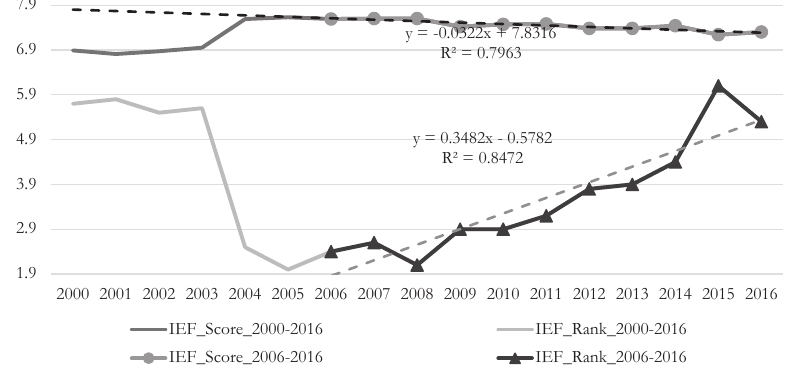
Fig. 1 – The Fraser Institute Economic Freedom. Source: own processing by The Fraser Institute (2018) According to the author Pavelková et al. (2009 in Kozubikova, et al., 2019): “SMEs are of a